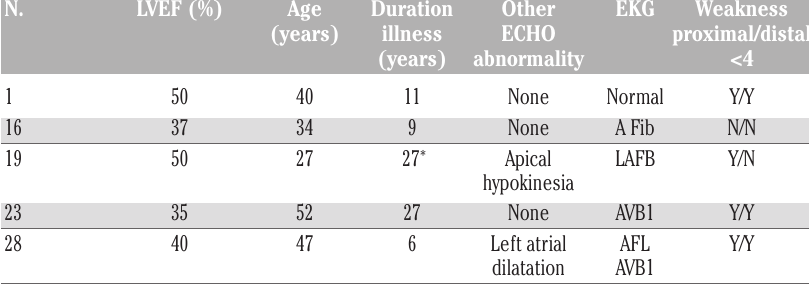
Table 2. Characteristics of adult myotonic dystrophy type 1 patients with systolic dys- function.